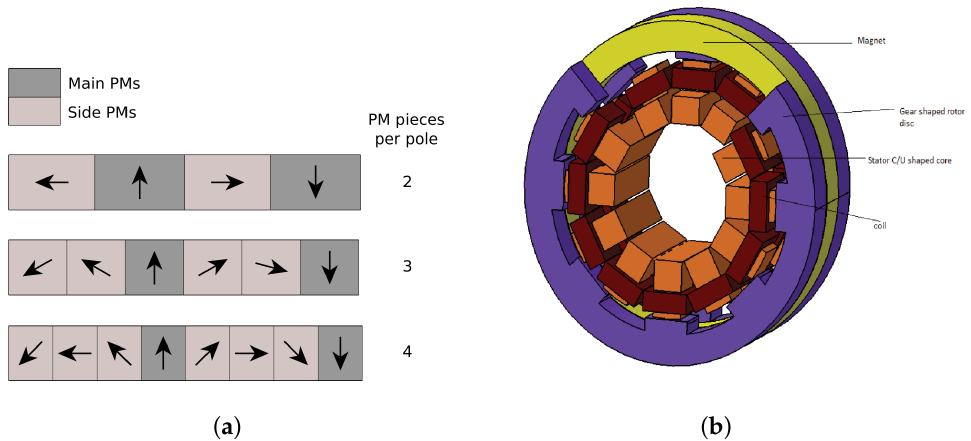
Figure 8. ( a ) Three examples of Halbach arrays, ( b ) PM ring between two iron cores